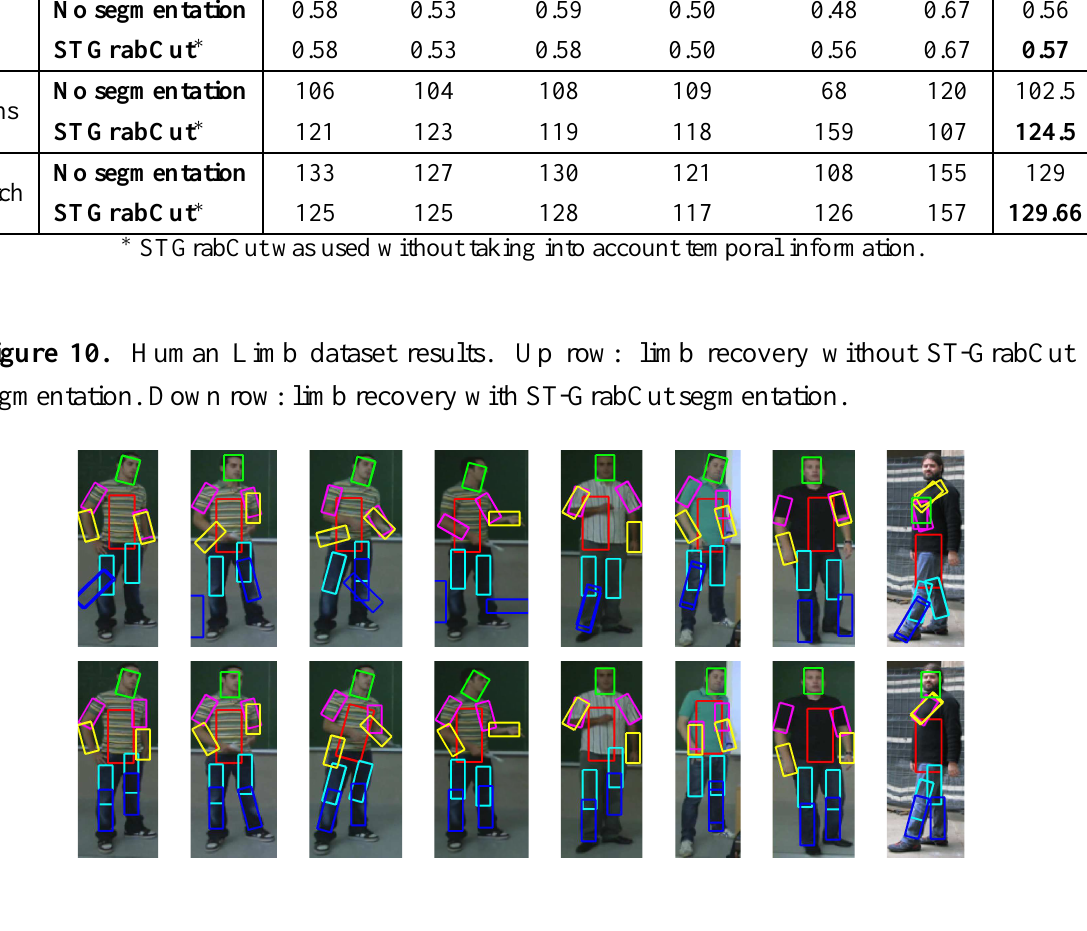
Table 5. Overlapping percentages between body parts (intersection over union), wins (comparing the highest overlapping with and without segmentation), and matching (considering only overlapping greater than 0.6). Trunk Up-arms Up-legs Low-arms Low-legs Head Mean